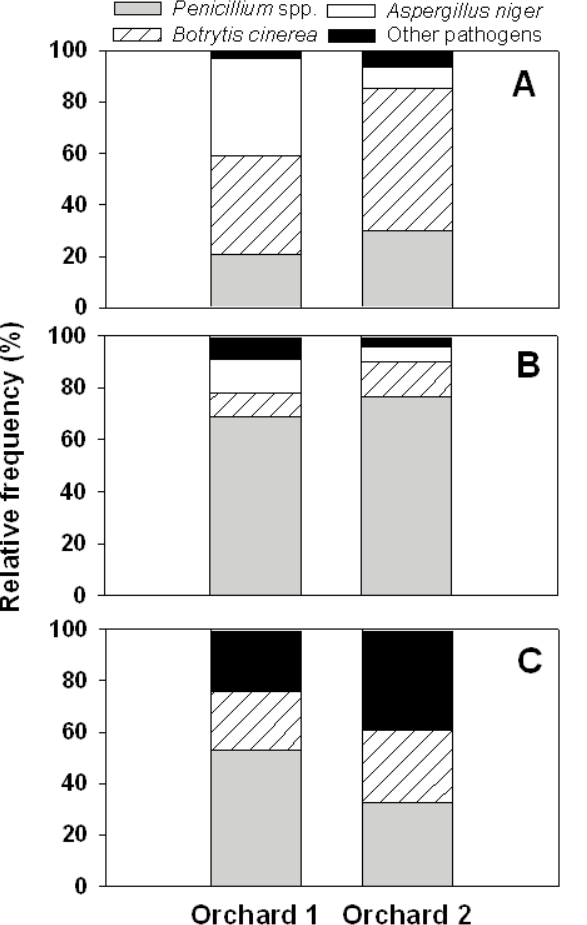
Figure 3. Relative frequency of pathogens causing posthar - vest diseases on pomegranates cv. Mollar de Elche from two orchards. The fruit were surface-disinfected (A) or arti - ficially wounded (B) and incubated at 20ºC for 15 weeks, or stored at 5ºC for 27 weeks (C). Data from the 2006